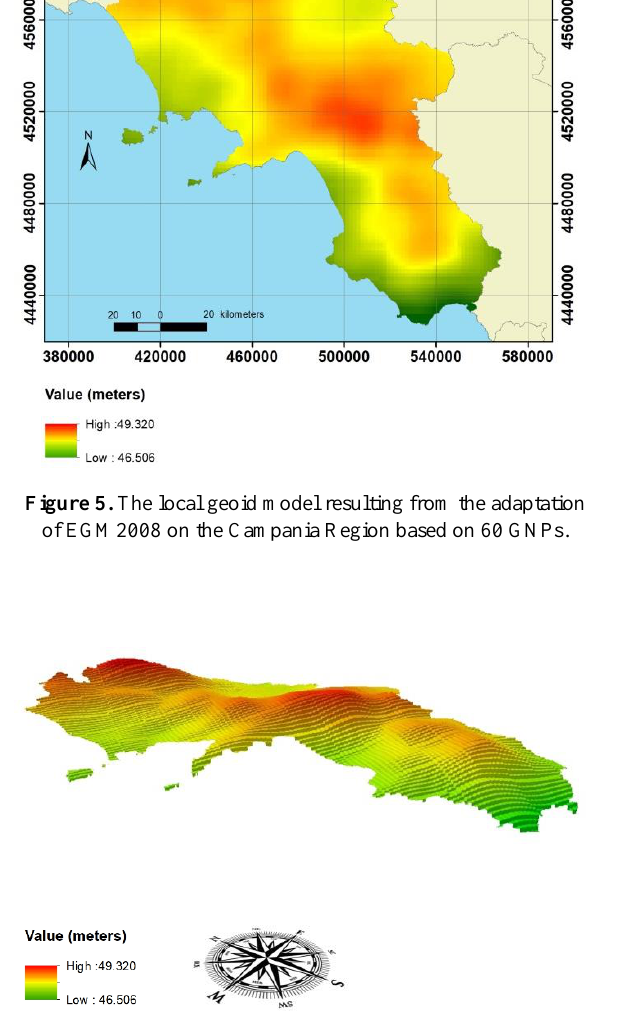
Figure 6 . 3D representation of the best performing local geoid model obtained for Campania Region (geoid undulation values are multiplied by an amplifying